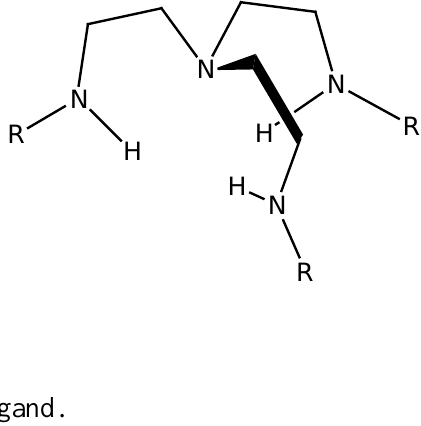
Figure 2. A symetrical tripodal